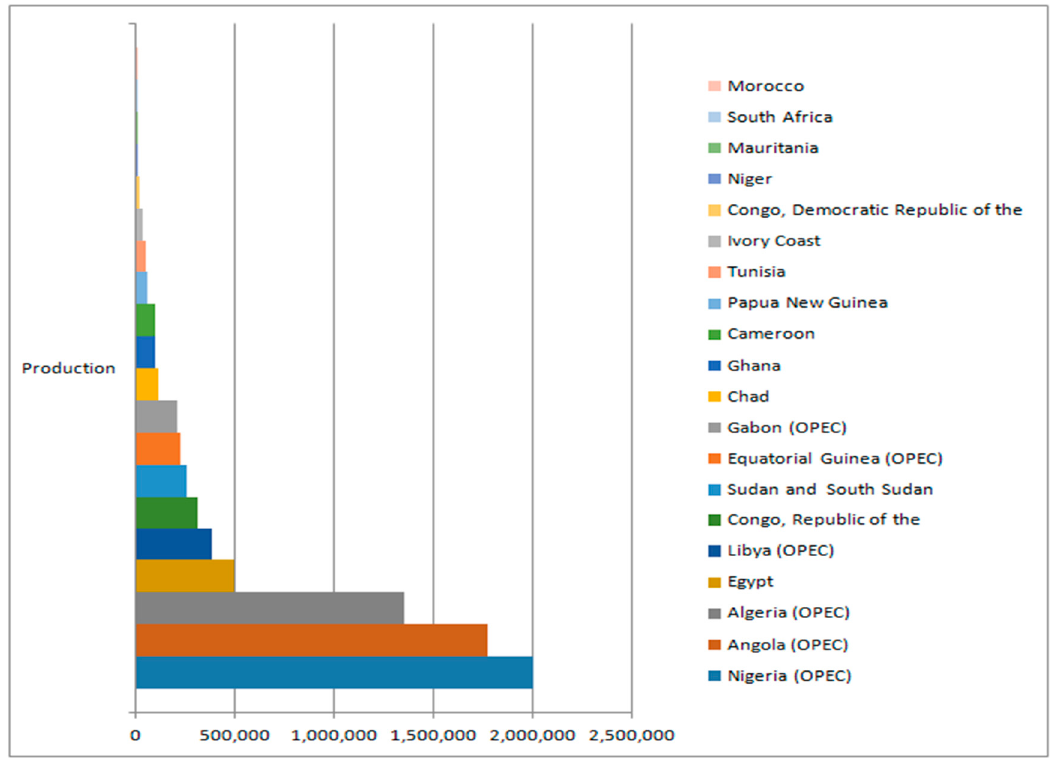
Figure 2. Oil distribution by daily production per million barrels. Source: World Bank data group.